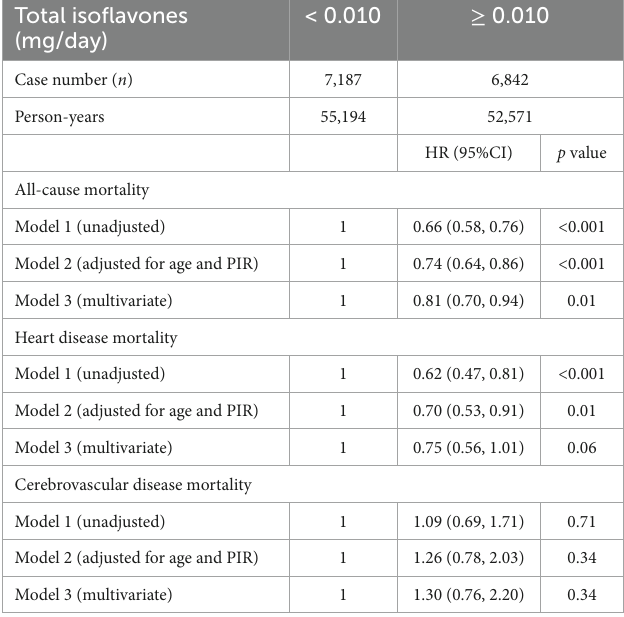
(Supplementary Figure S2K). The reduction in all-cause mortality was only associated with total flavonoid intake in people aged 50 and above, female, and (Supplementary Figure S2D). In the female participants, blacks, non-alcohol users, and former drinkers, the intake of total flavonoids was inversely associated with heart disease mortality, while the intake of flavonoids was positively associated with heart disease mortality in mild alcohol users (Supplementary Figure S2H). The inverse association between intake of total flavonoid and cerebrovascular disease mortality was only observed in the male participants (Supplementary Figure S2L).